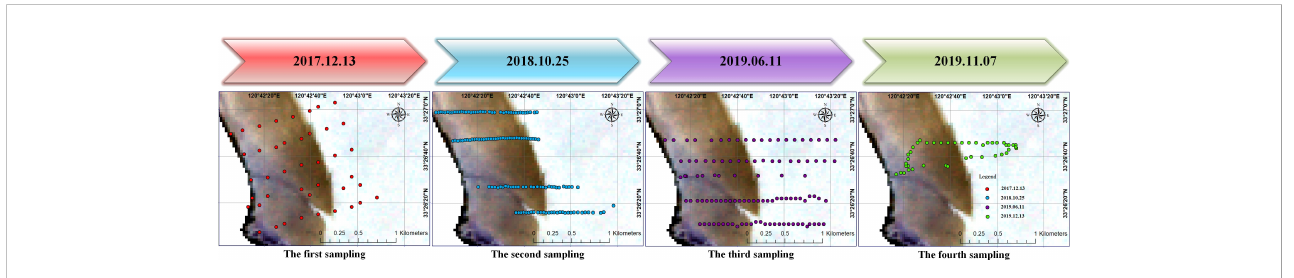
FIGURE 2 Location of Field Sampling Points in the Study Area.